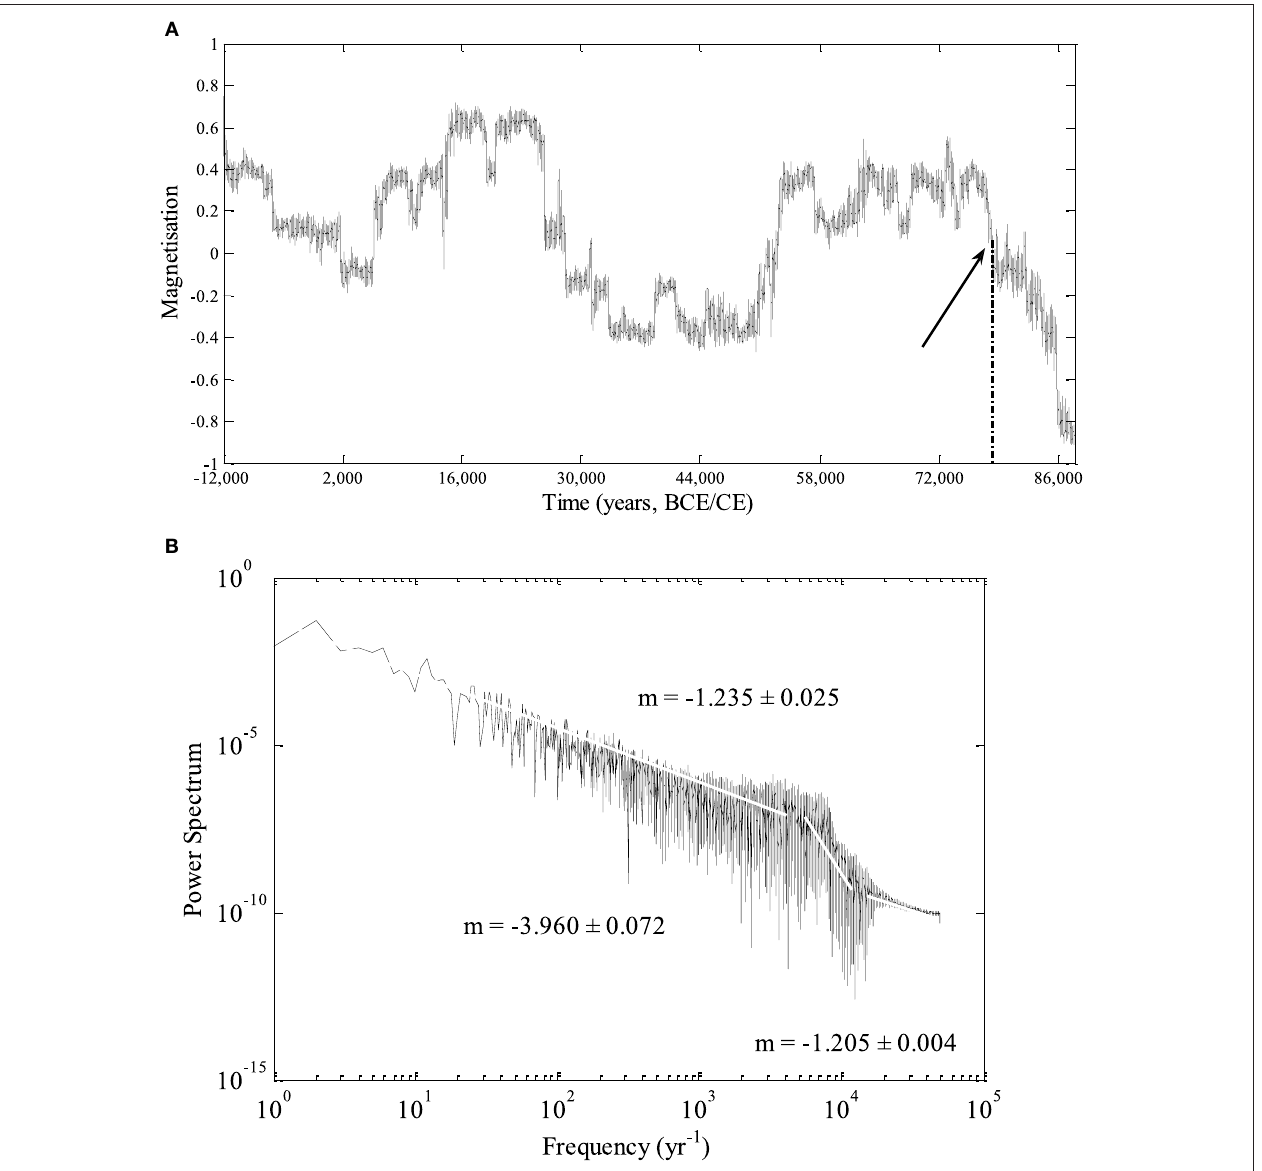
FIGURE 10 | (A) The time series generated by the LCS model which comprises 100,000 years, from same time series.